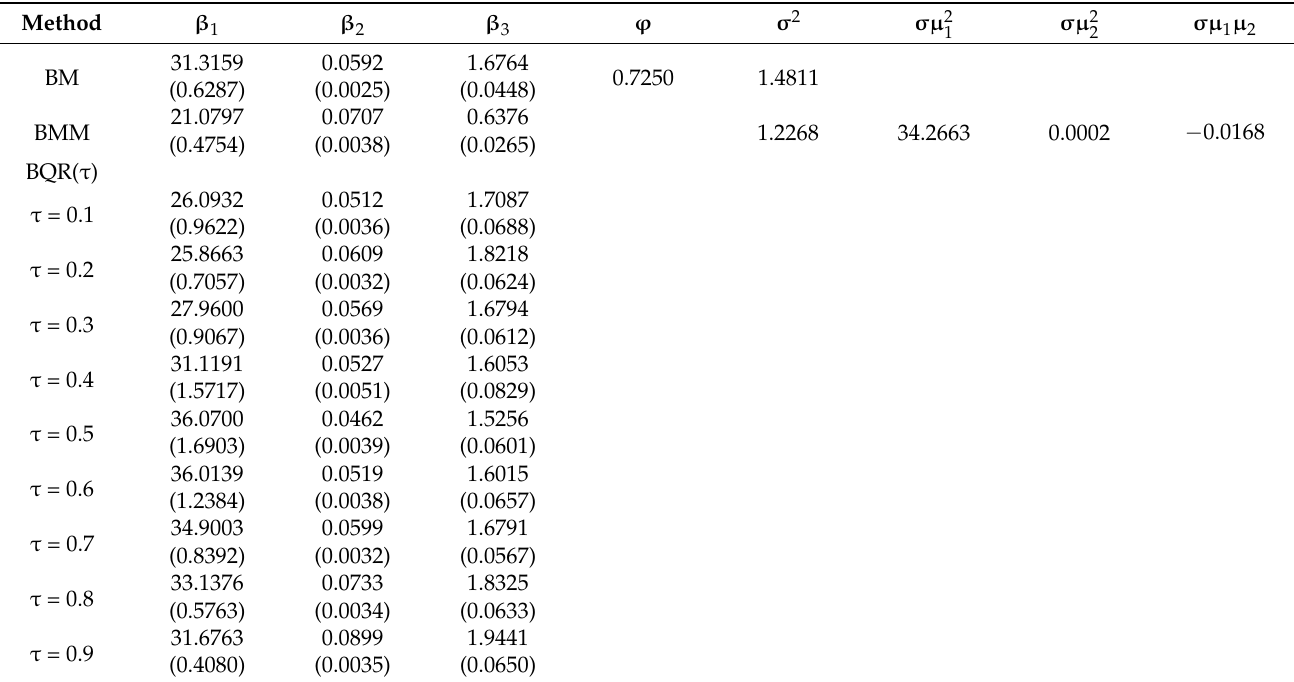
Table 2. Parameter estimates (standard error) for the basic model (BM), basic mixed effects model (BMM) and basic quantile regression (BQR) model at nine quantiles ( τ ).